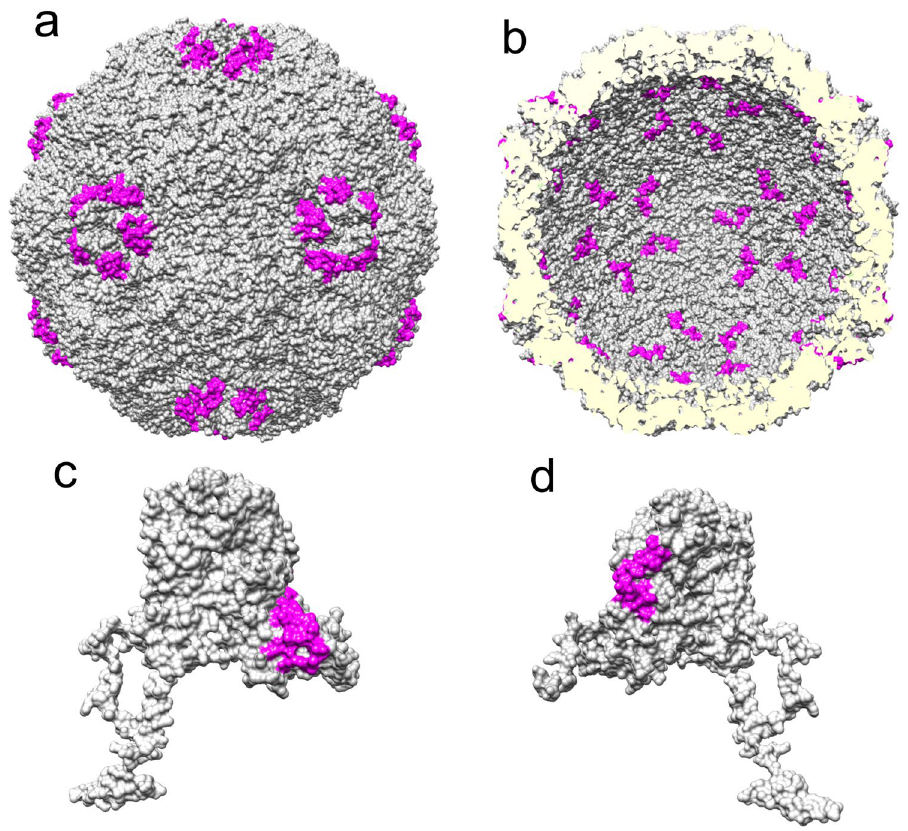
Figure 2. RCAP of capsid protein VP1. RCAP results of recombinantly-expressed VP1 are shown on the HPeV1 model (PDB: 4Z92). ( a ) Peptides from VP1 identified by RCAP that are localized to the outer capsid surface ( b ) Peptides from VP1 identified by RCAP that localize to the inner capsid surface. ( c ) Locations of the peptides that contact RNA on a monomer of VP1 with a view corresponding to the outer capsid surface whereas ( d ) A view of VP1 that corresponds to the inner capsid